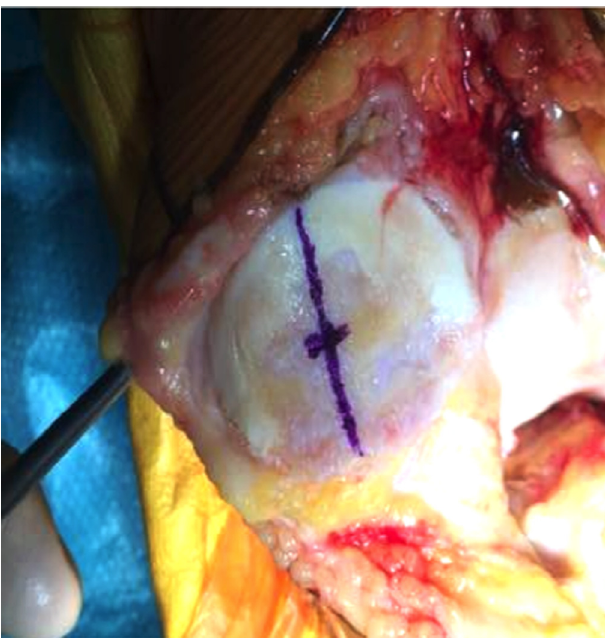
Figure 2. Midpoint of the vertical ridge identi fi ed as the OCPP.